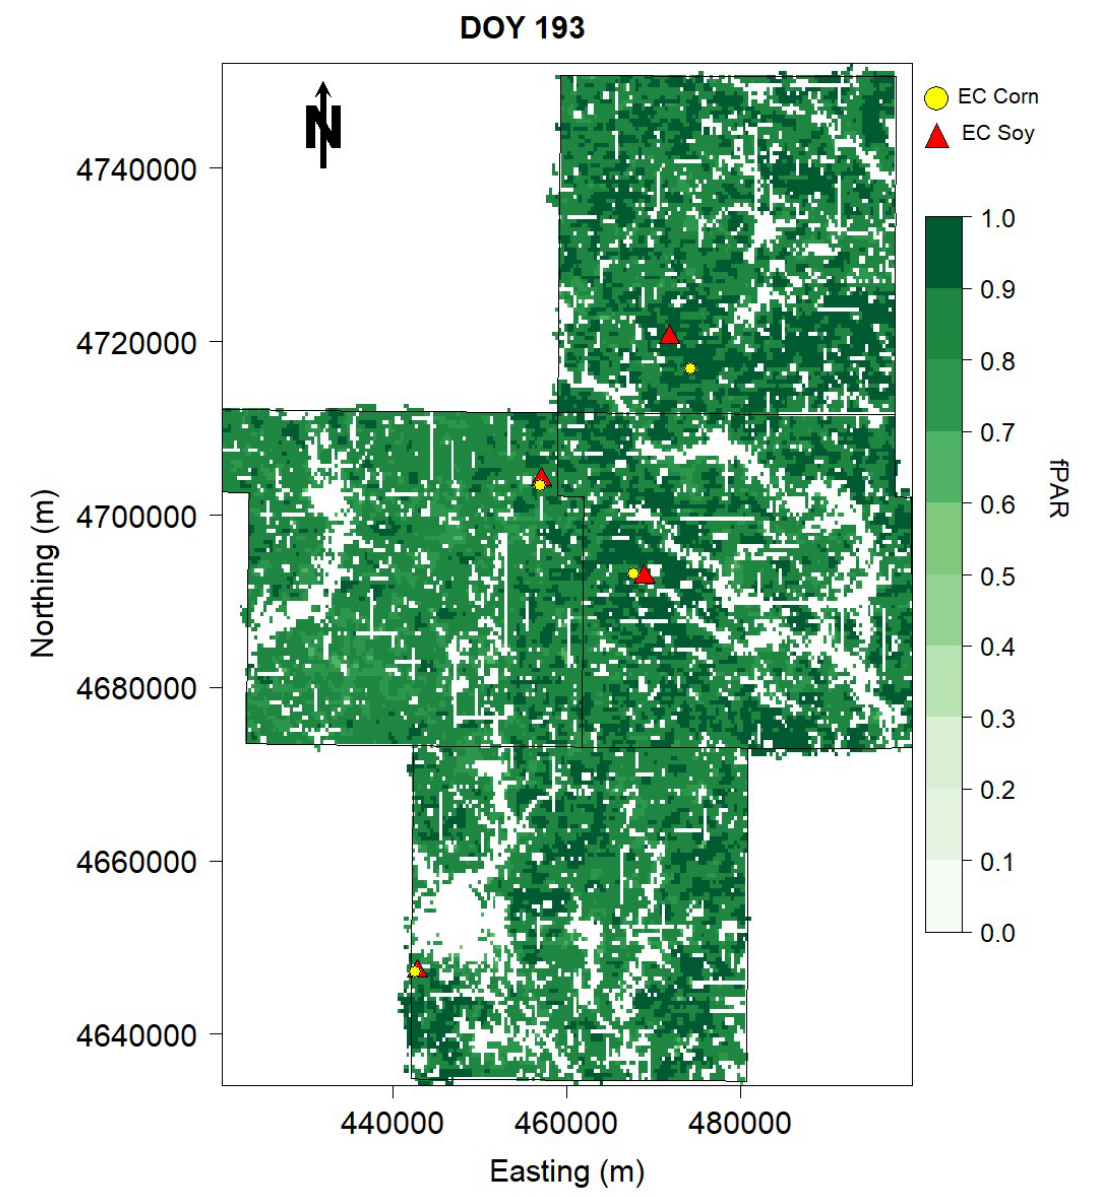
Figure 4. MODIS fPAR product (MCD15A2H) for DOY 193 in 2016 in four Iowan counties for corn and soybean fields. The red triangles and yellow circles show the location of the eddy covariance (EC) stations on soybean and corn fields, respectively; fPAR: fraction of absorbed photosynthetic active